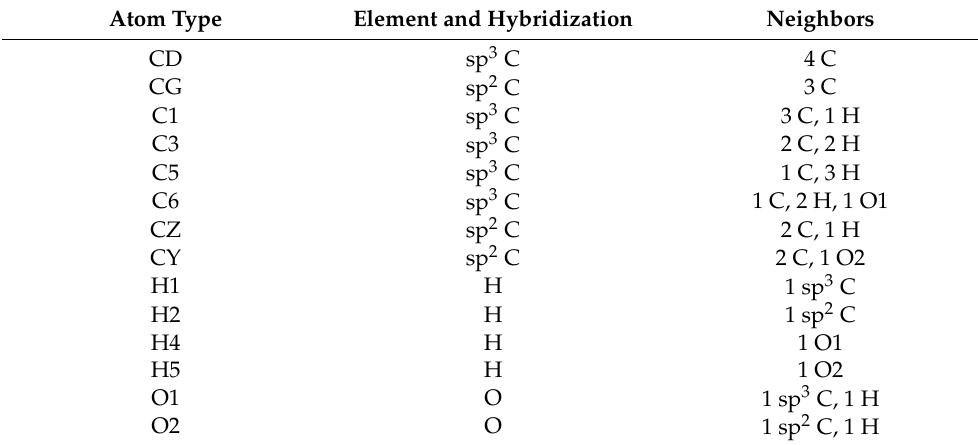
Table A1. Definition of the atom types occurring in this study.